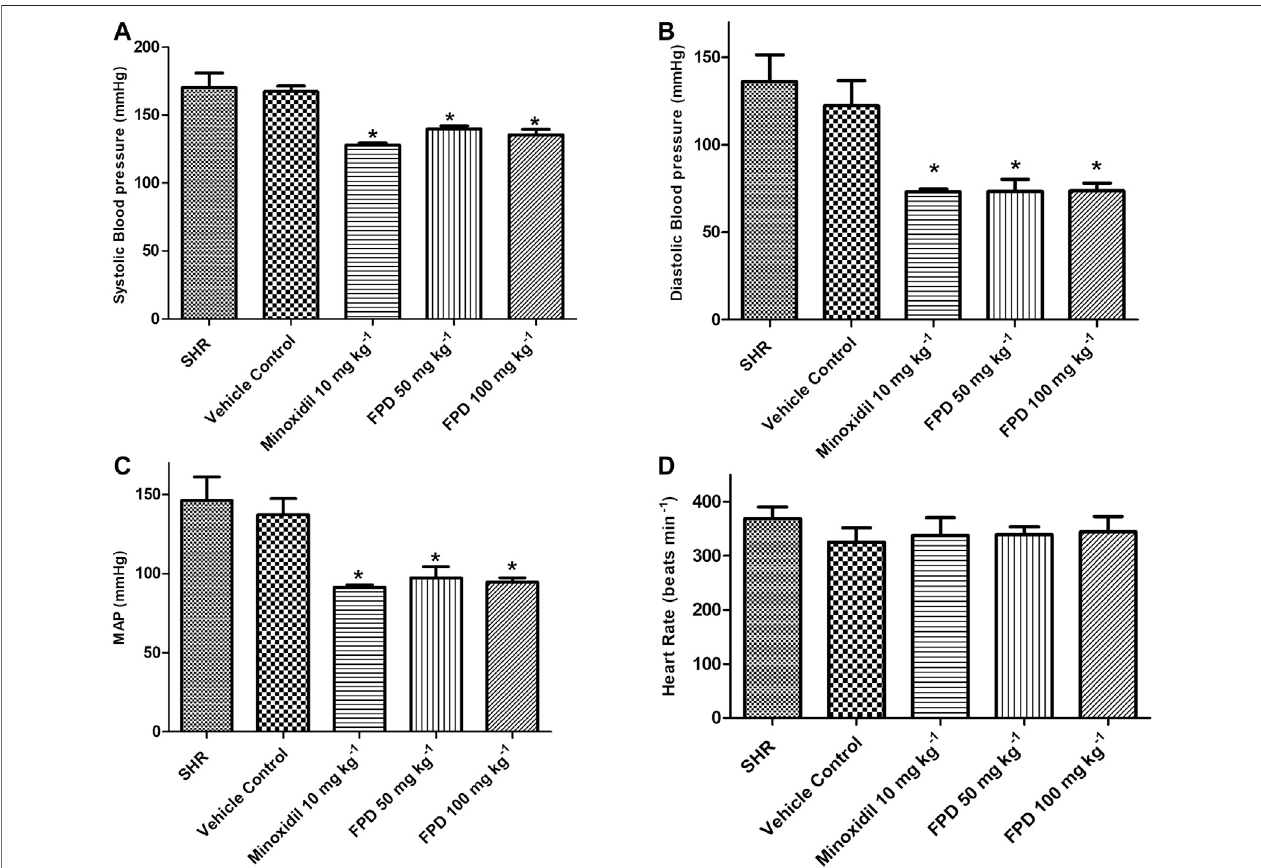
FIGURE 1 | Effect of minoxidil (10 mg kg − 1 ) and FPD (50 mg kg − 1 and 100 mg kg − 1 ) once daily for 14 days on SBP, DBP, MAP, and HR in spontaneously hypertensive rats (A – D) (mean ± S.E.M., n (cid:2) 6; p < 0.05, * signi fi cance compared to